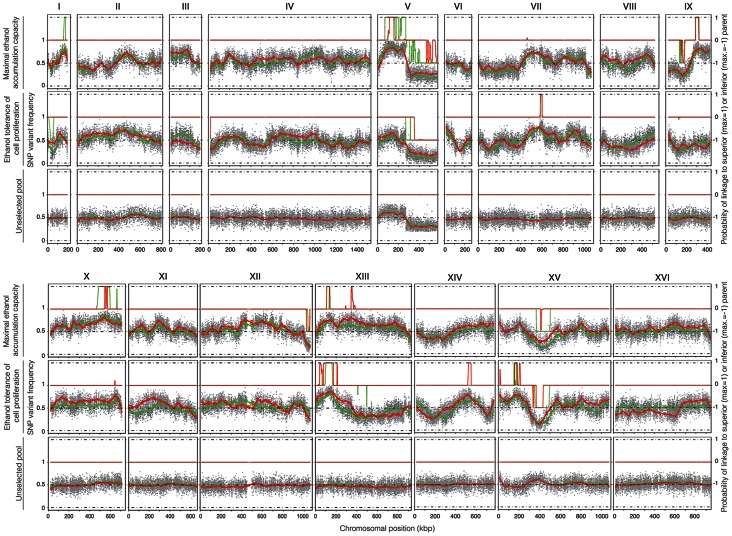
QTL mapping of maximal ethanol accumulation capacity (pool 1) and high ethanol tolerance of cell proliferation (pool 2).22 selected segregants (pool 1) with high ethanol accumulation capacity and 32 selected segregants (pool 2) with high ethanol tolerance of cell proliferation were pooled for whole genome sequencing analysis, which was performed by two independent companies utilizing the Illumina platform (BGI in green and GATC Biotech in red). An unselected pool composed of 237 segregants (pool 3) was also sequenced twice to assess proper segregation of all chromosomes and possible linkage to inadvertently selected traits. The probability of linkage to the superior or the inferior parent, as determined with the HMM, is indicated on the right.